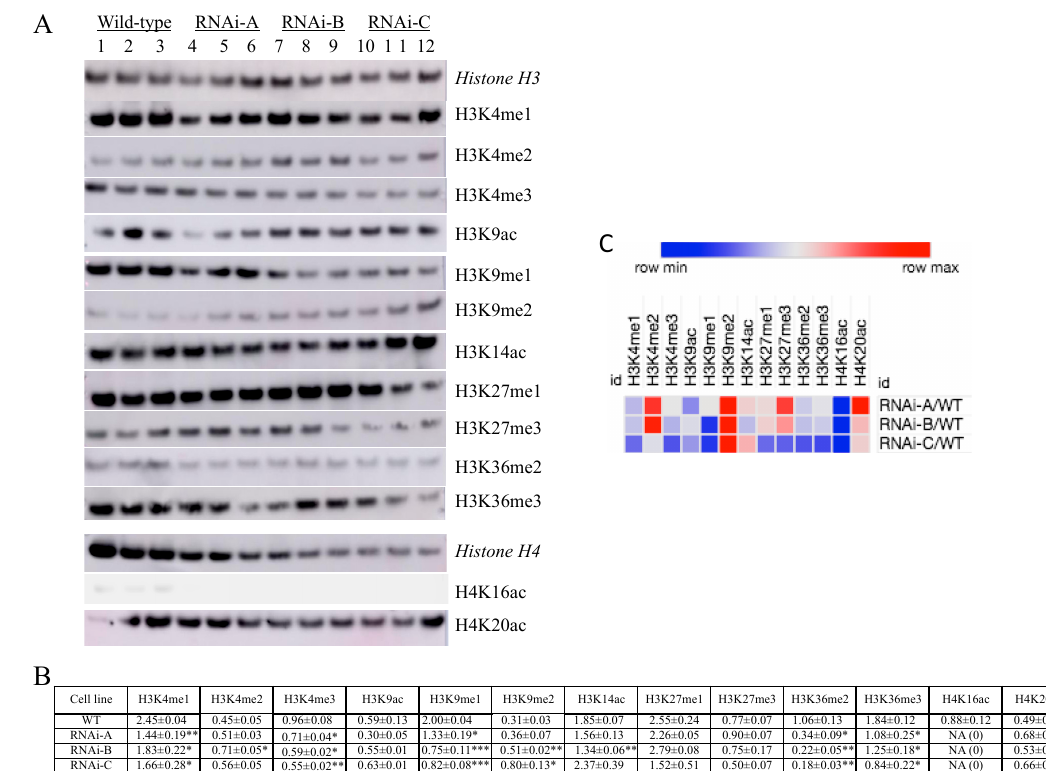
Figure 6. Immunoblot analysis of histone H3 and H4 PTMs at the level of the total chromatin of wild-type and three independent VvMSA -RNAi transgenic lines (biological replicates) of grape embryogenic cells 41B. ( A ) Histone PTMs’ immunodetection of the four cell lines, each tested in three technical replicates. The loading controls stained with Ponceau S are presented in Figure S5. ( B ) The quantified HPTM data were first normalized to those of their respective native histone (H3 or H4). The values of the three technical replicates for each of the four tested cell lines were presented as mean ± SEM. The asterisks denote the level of significant difference between the wild-type and each of the RNAi cell lines evaluated by unpaired t test: * p < 0.05; ** p < 0.01; *** p < 0.001. In the column of H4K16ac statistics was not applicable (NA) because of undetectable signal in the three tested RNAi cell lines. ( C ) Heat map of the mean VvMSA -RNAi/WT ratios of the three biological replicates (Morpheus, https://software.broadinstitute.org/morpheus; accessed on 1 May 2021). The heat map was built using the mean VvMSA -RNAi/WT values presented in Table S3.